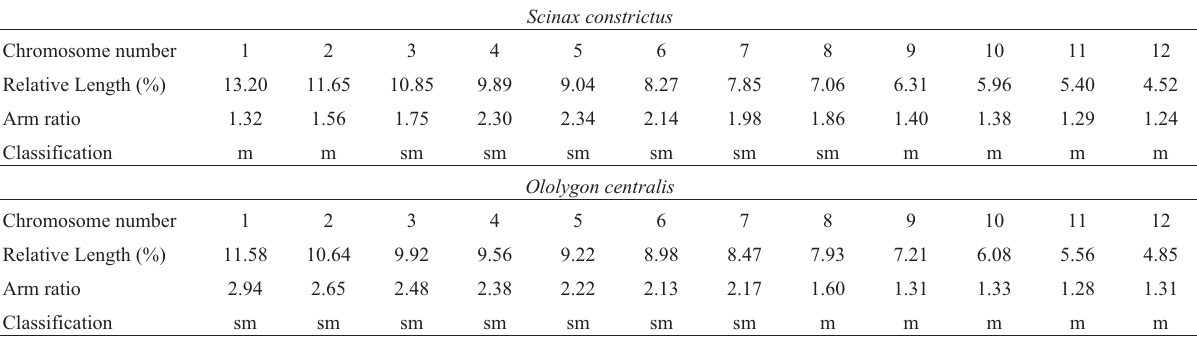
Table 1 - Morphometric parameters of Scinax constrictus and Ololygon centralis karyotypes. Chromosome classification followed Green and Session (1991). (m) metacentric; (sm) submetacentric; (st) subtelocentric; (t) telocentric. Scinax